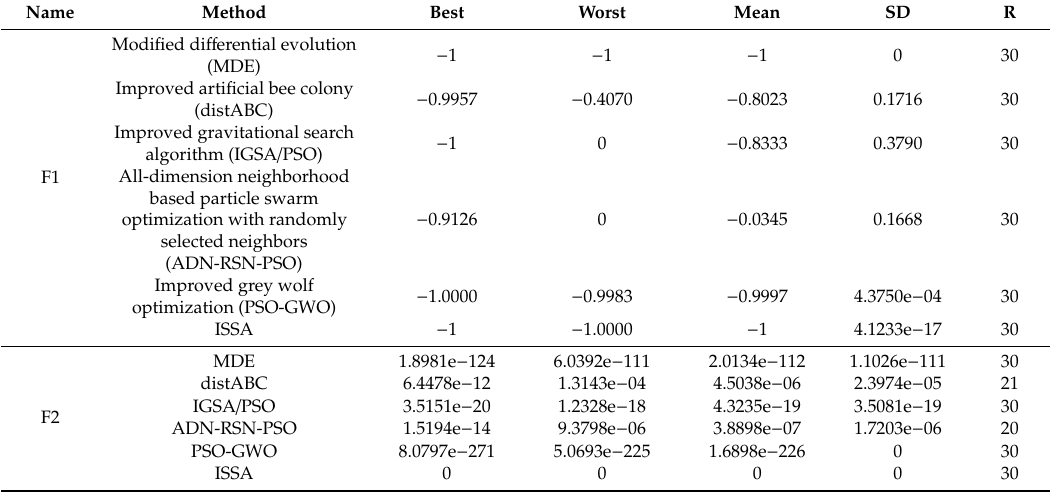
Table 8. The convergence results of